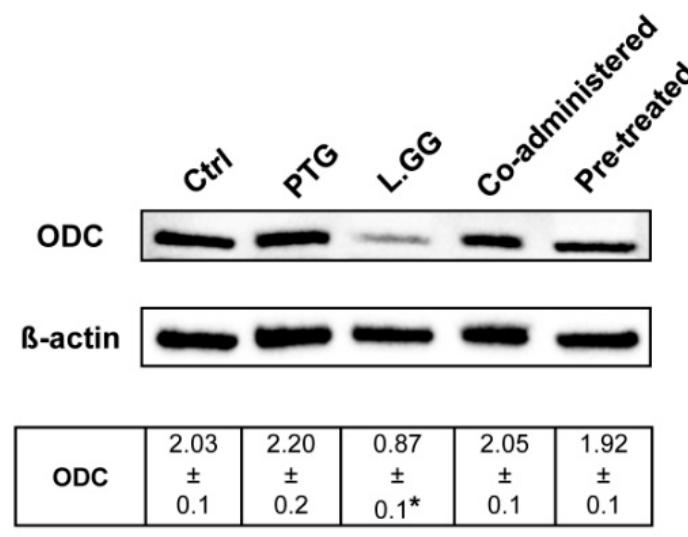
Figure 3. Western Blot Analysis of ODC in jejunal tissue samples from control and treated rats. Ctrl (without treatment); PTG (sensitized with 1000 U IFN- γ and treated with PTG 50 µg/day for ten days); L.GG (treated with L.GG 1 × 10 9 CFU for ten days); Co-administered (sensitized with 1000 U IFN- γ and co-administered with PTG and L.GG for ten days); Pre-treated (sensitized with 1000 U IFN- γ , pre-treated with PTG for ten days, and then administered with L.GG for further ten days). of the intensity of bands, calibrated to the intensity of the β -actin band. All data represent the results of three different experiments (mean ± SEM). Data were analyzed by Kruskal-Wallis analysis of variance and Dunn’s Multiple Comparison